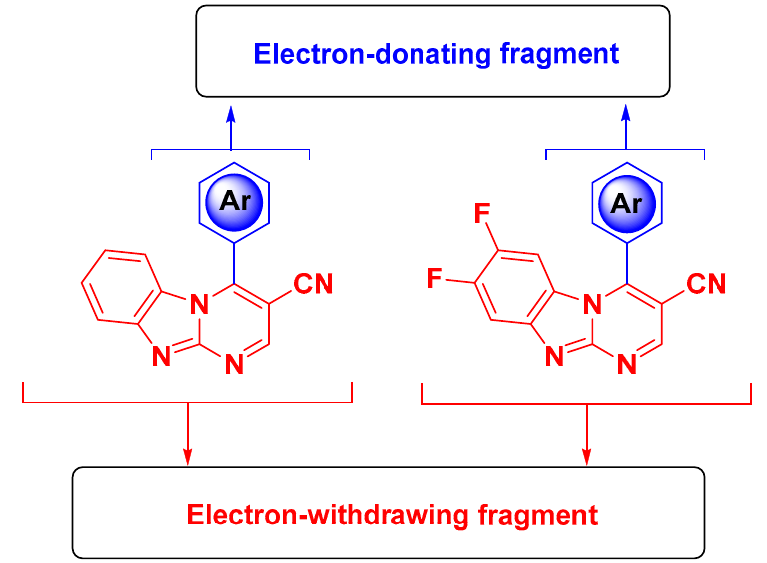
Figure 9. Donor-acceptor structure 4-aryl-substituted benzo[4,5]imidazo[1,2- a ]pyrimidine chromo- phors 6a–f .